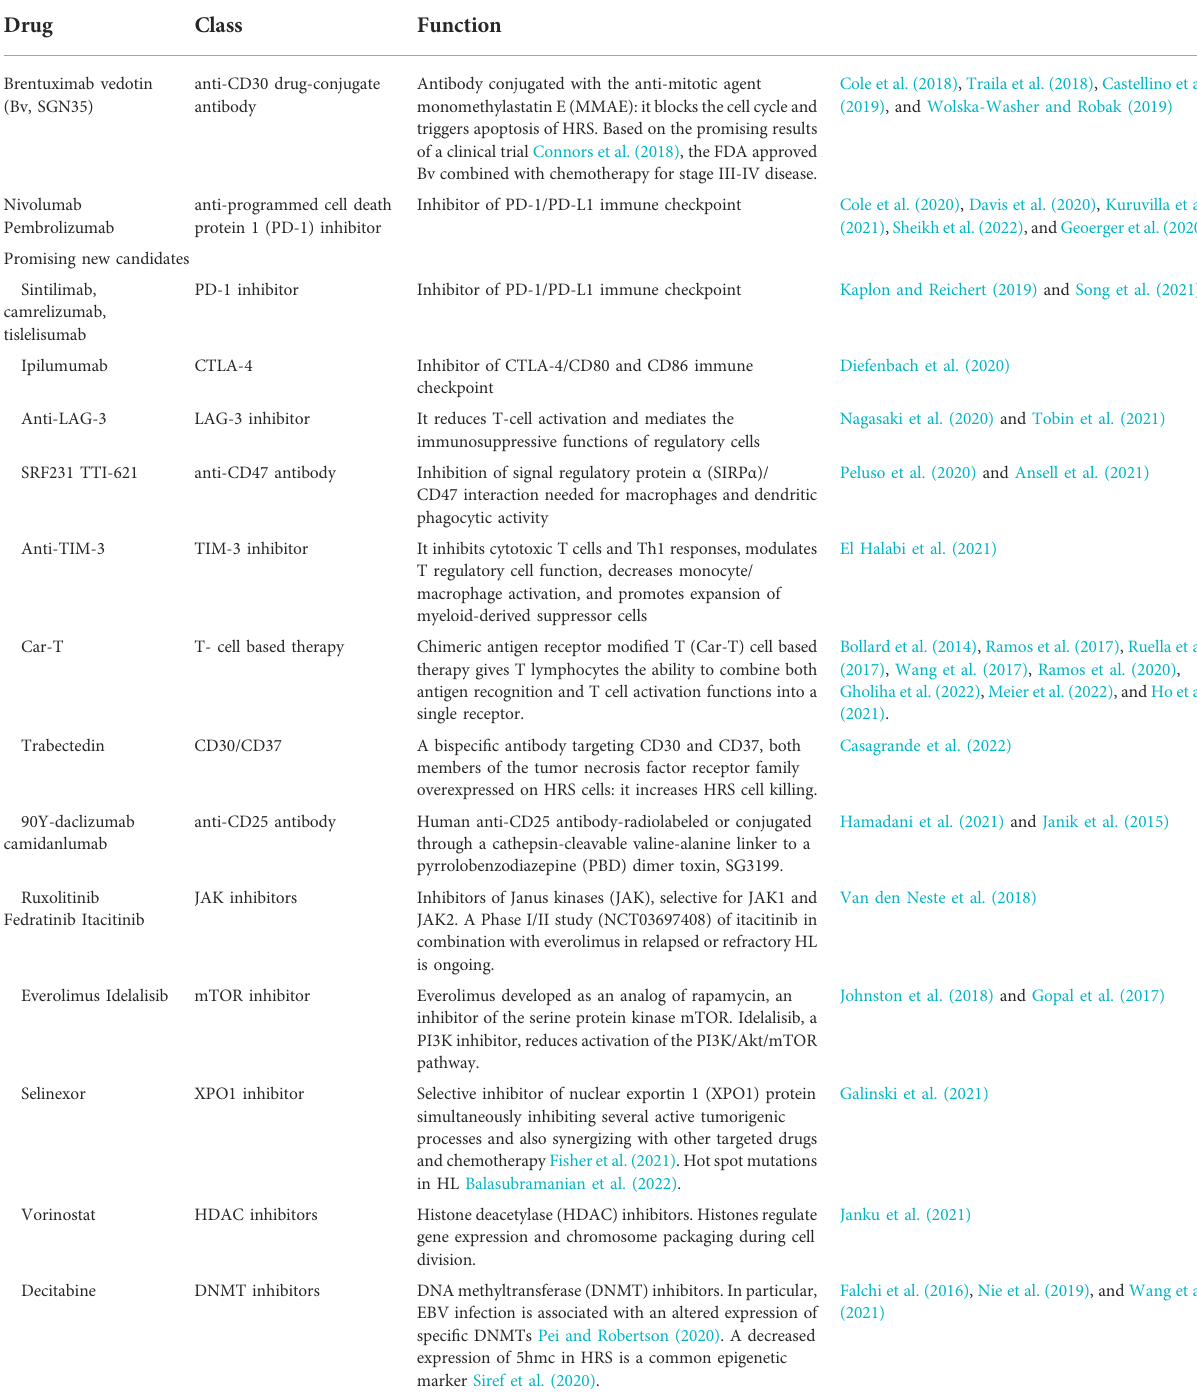
TABLE 5 New drugs and targeted treatments for children and young adults with